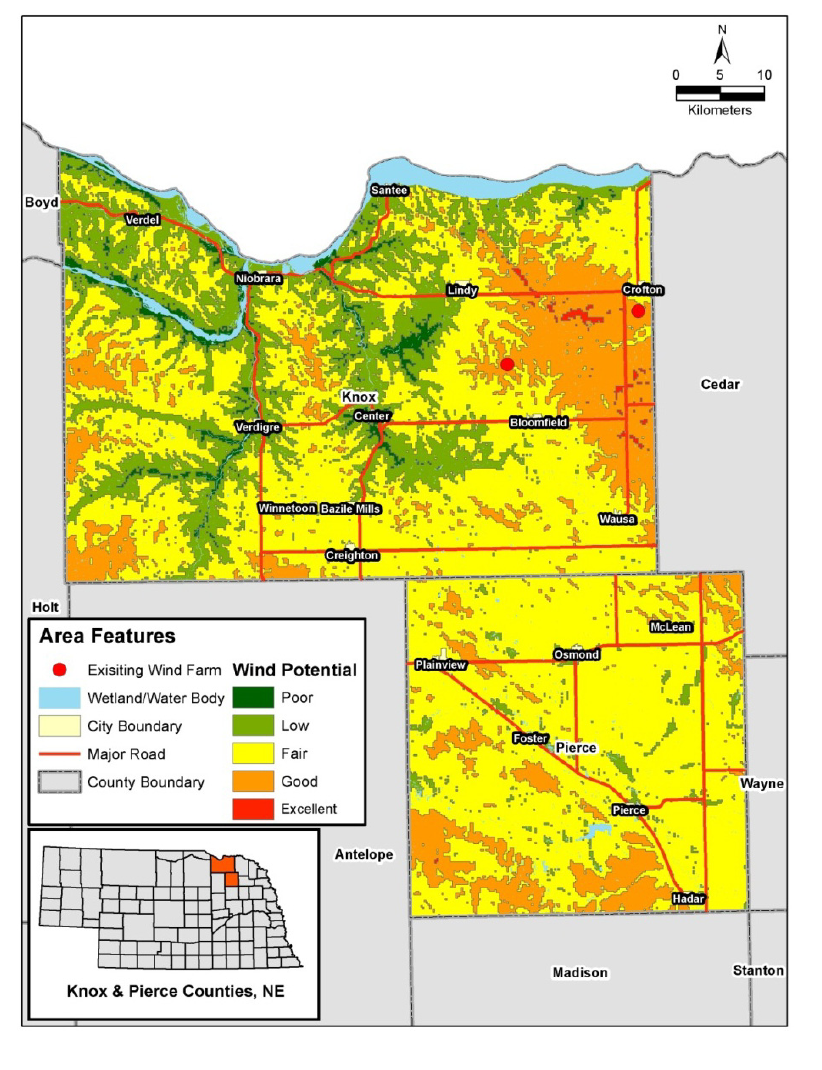
Figure 2. Location map of study area, Knox and Pierce Counties,